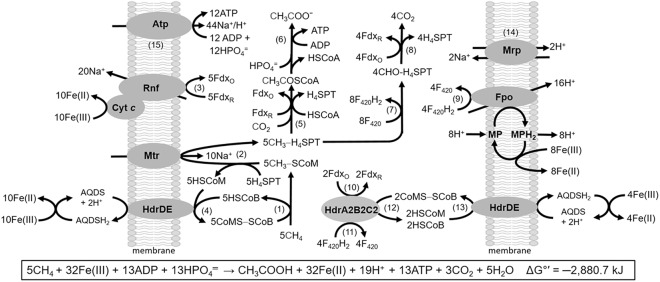
Pathway proposed for Fe(III)-dependent methane oxidation and conservation of energy by M. acetivorans. Enzymes not discussed in the text: CO dehydrogenase/acetyl CoA synthase (Rxn. 5); acetate kinase and phosphotransacetylase (Rxn. 6); coenzyme F420 (F420)-dependent methylene-H4SPT reductase, F420-dependent methylene-H4SPT dehydrogenase, methenyl-H4SPT cyclohydrolase, formylmethanofuran:H4SPT formyltransferase (Rxn. 7); formylmethanofuran dehydrogenase (Fwd) (Rxn. 8). MP, methanophenazine; AQDS, anthraquinone-2,6-disulfonate; FdxO, oxidized ferredoxin (Fdx); FdxR, two-electron-reduced ferredoxin (Fdx2-). Reproduced by permission (Yan et al., 2018).